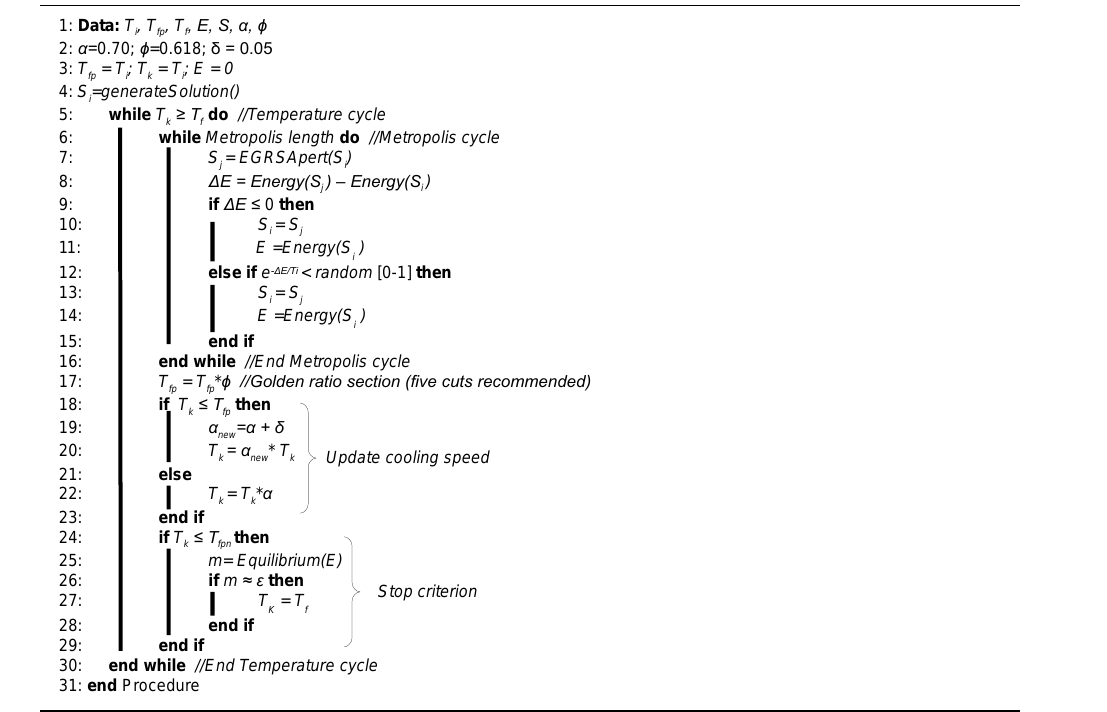
Algorithm 4. EGRSA algorithm Procedure. Algorithm 3 EGRSA algorithm Procedure